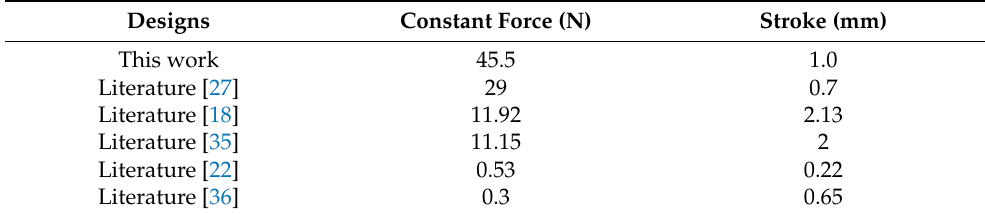
Table 4. Comparison of the existing